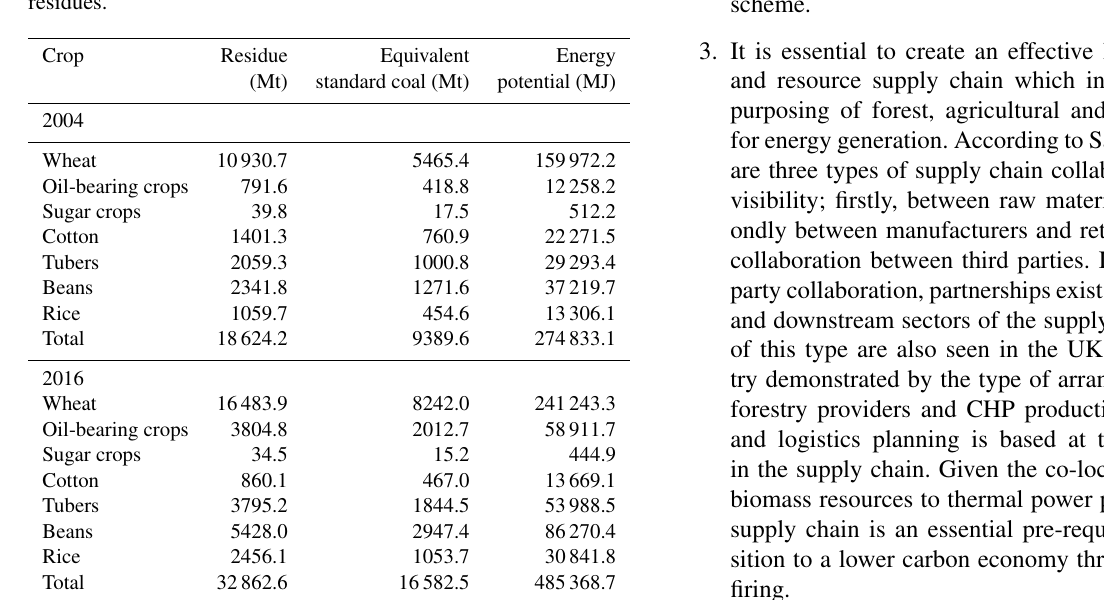
Table 1. Annual estimates of bioenergy potential from crop